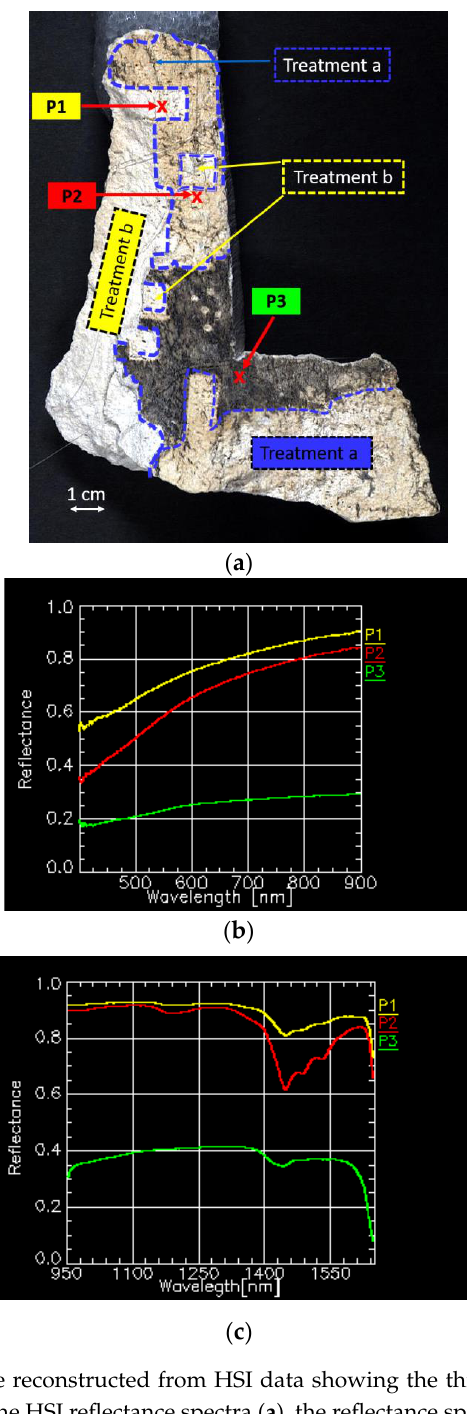
Figure 4. The RGB image reconstructed from HSI data showing the three points of the limestone fragment used to extract the HSI reflectance spectra ( a ), the reflectance spectra extracted from the Vis cube image ( b ) and the NIR cube image ( c